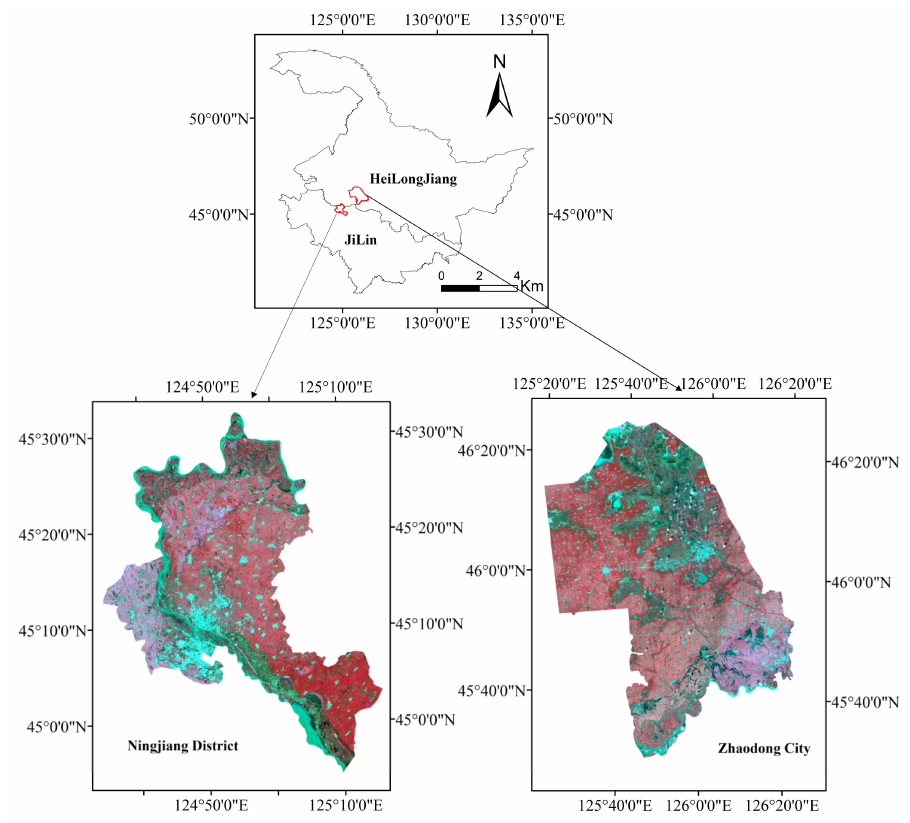
Figure 1. Study areas with false-color images (R: band 4; G: band 3; B: band